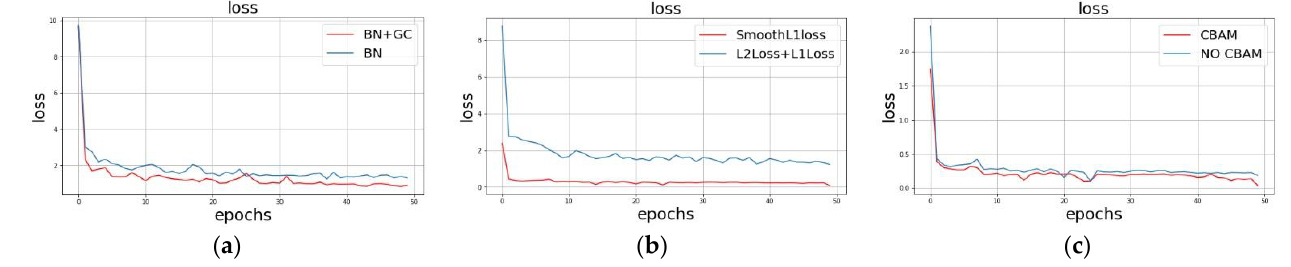
Figure 16. Loss comparison chart. ( a ) BN, BN+GC loss curve; ( b ) L2Loss+L1Loss, SmoothL1Loss loss curve. ( c ) NO CBAM, CBAM loss curve.